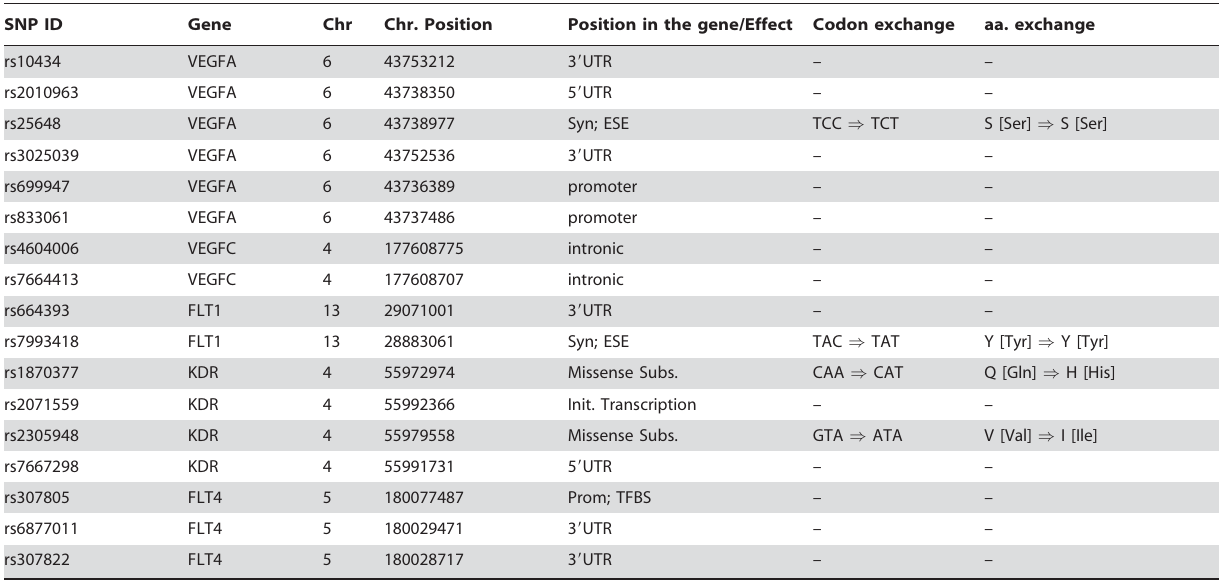
Table 1. Chromosomal locations, positions and biological effects of investigated gene